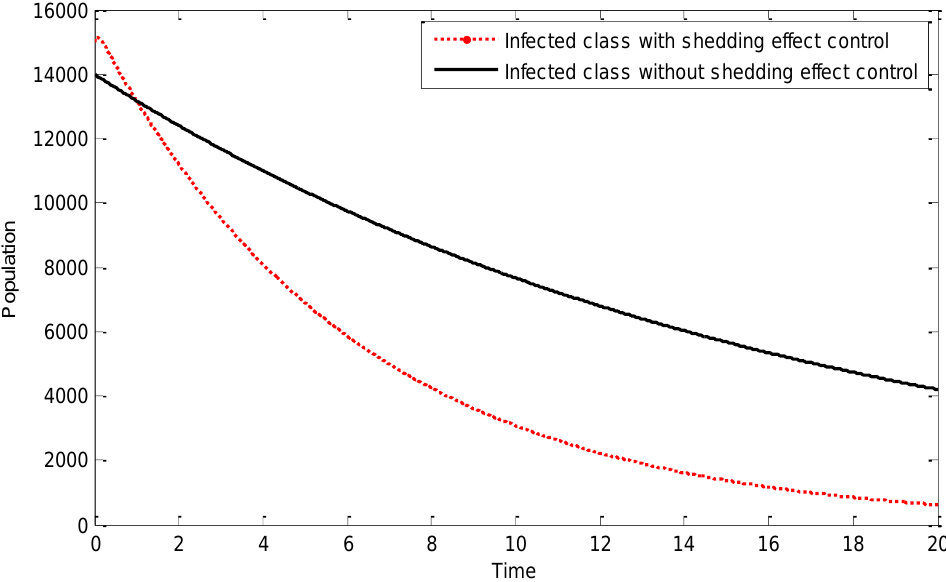
Figure 5. Comparing the dynamics of infected population with and without control.